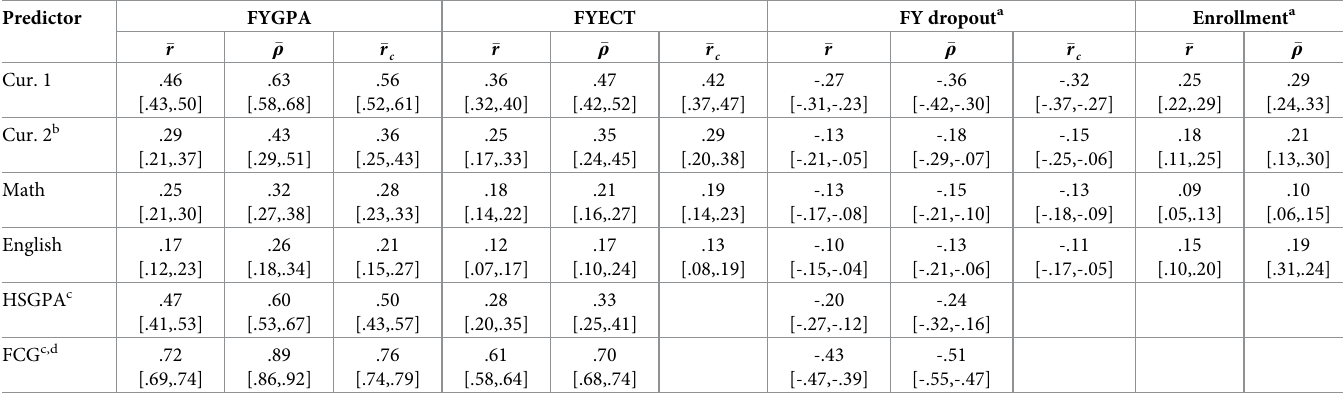
Table 1. Correlations between predictors and first year academic outcomes aggregated across cohorts.